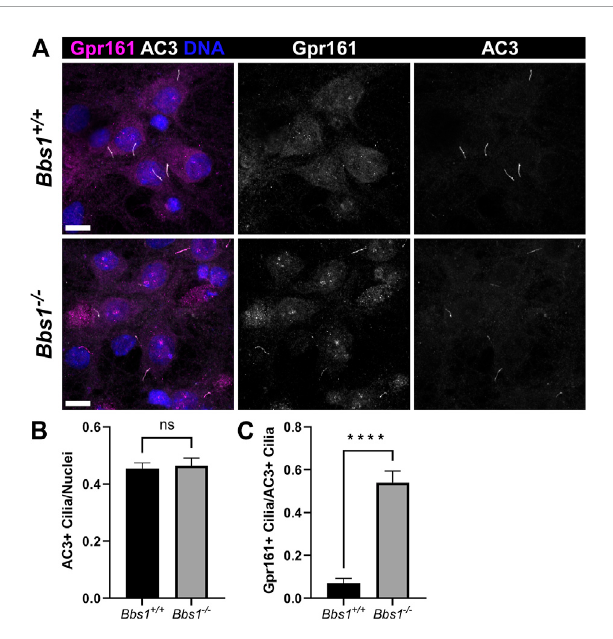
Gpr161 accumulates in cilia on Bbs1 − / − hippocampal neurons (A) Representative images of cultured hippocampal neurons from Bbs1 +/+ (upper row) and Bbs1 − / − (lower row) mice colabeled for Gpr161 (magenta) and AC3 (white). Note that Gpr161 ciliary localization is more pronounced in the Bbs1 − / − culture (middle panels). Nuclei are stainedwithDRAQ5(blue).Scalebarsrepresent10 µm (B) Quanti fi cation of AC3-positive cilia relative to nuclei reveals a similar fraction between Bbs1 +/+ (353/748; n = 3 animals) and Bbs1 − / − (286/627 nuclei; n = 3 animals) cultures (C) Quanti fi cation of Gpr161-positive cilia relative to AC3-positive cilia reveals a signi fi cant increase in Gpr161-positive cilia in Bbs1 − / − cultures (145/286; n = 3 animals), compared to Bbs1 +/+ cultures (18/353; n = 3 animals). Values are expressed as mean ± SEM. ns = not signi fi cantly different, **** p <